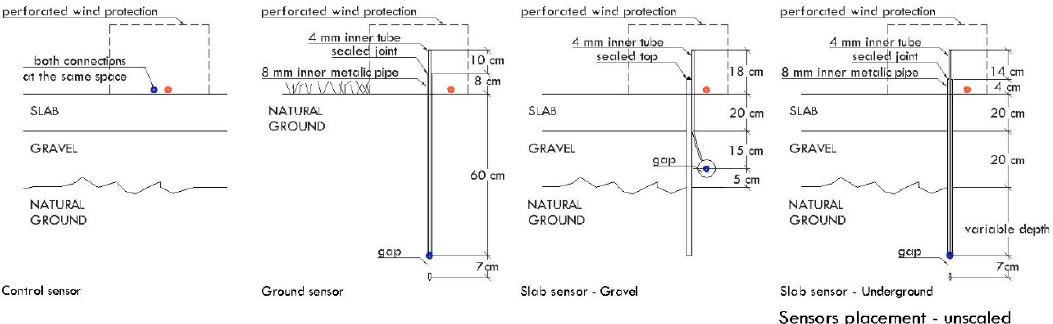
Figure 16. Tube positions for field test experiments.